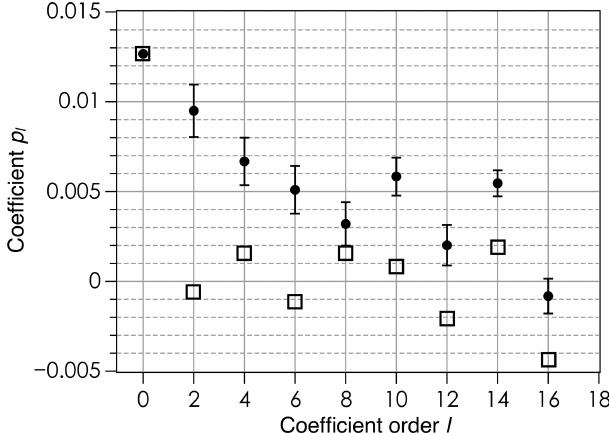
Figure 8. Coefficients p l in the expansion of P ( β ) according to Eq. (6) for a rotation about the Z axis (open squares) and a rotation about the Y axis (black circles) in the case of films deposited with an applicator. Odd-order coefficients are all zero.